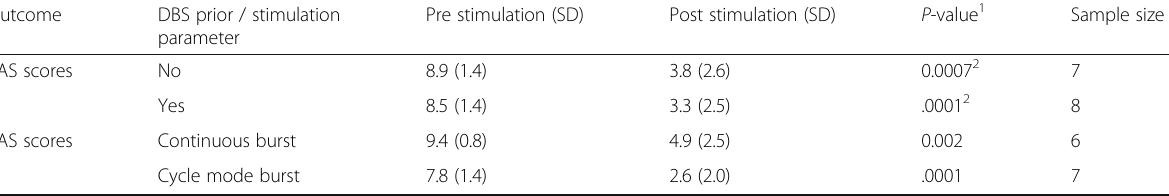
Table 3 Outcome measures pre and post stimulation therapy Outcome DBS prior / stimulation